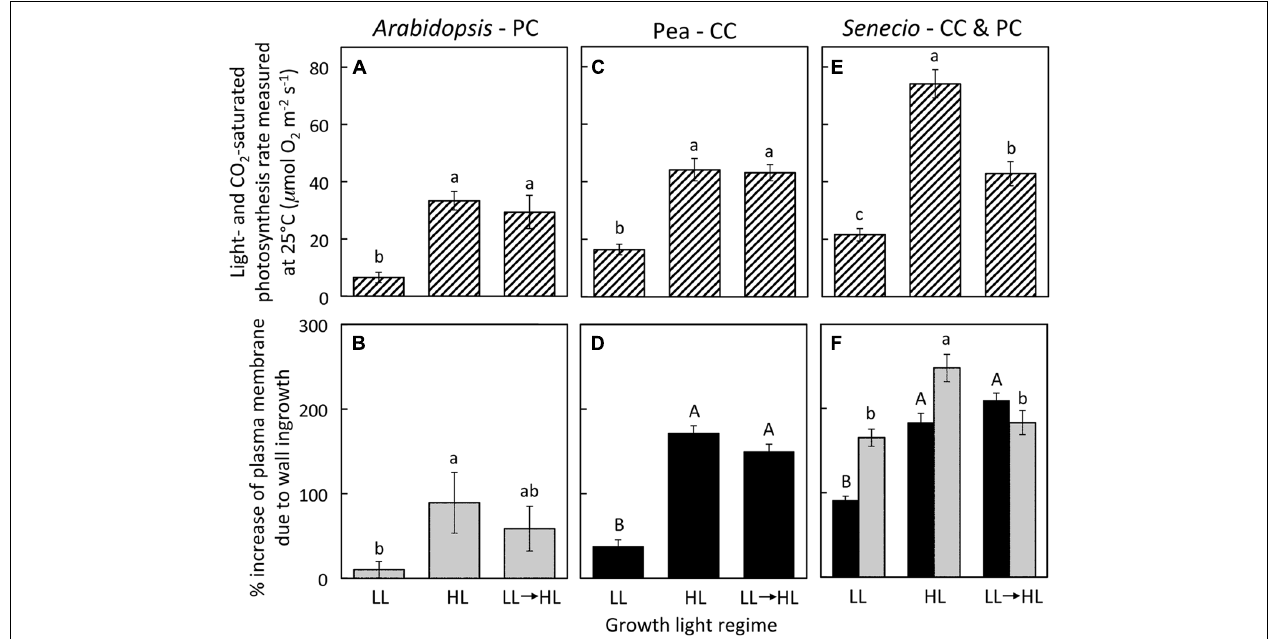
FIGURE 1 | (A,C,E) Foliar light- and CO 2 -saturated rate of photosynthetic oxygen evolution ascertained at 25 ◦ C and (B,D,F) percent increase in plasma membrane length due to cell wall ingrowths estimated from cross-sections of phloem transfer cells (parenchyma = PC, companion = CC) relative to the hypothetical membrane area in the absence of wall ingrowths in foliar minor veins of A. thaliana (A,B) , pea (C,D) , and S. vulgaris (E,F) that developed in low light (LL), high light (HL), or LL and then transferred to HL for seven days. Light-gray columns indicate